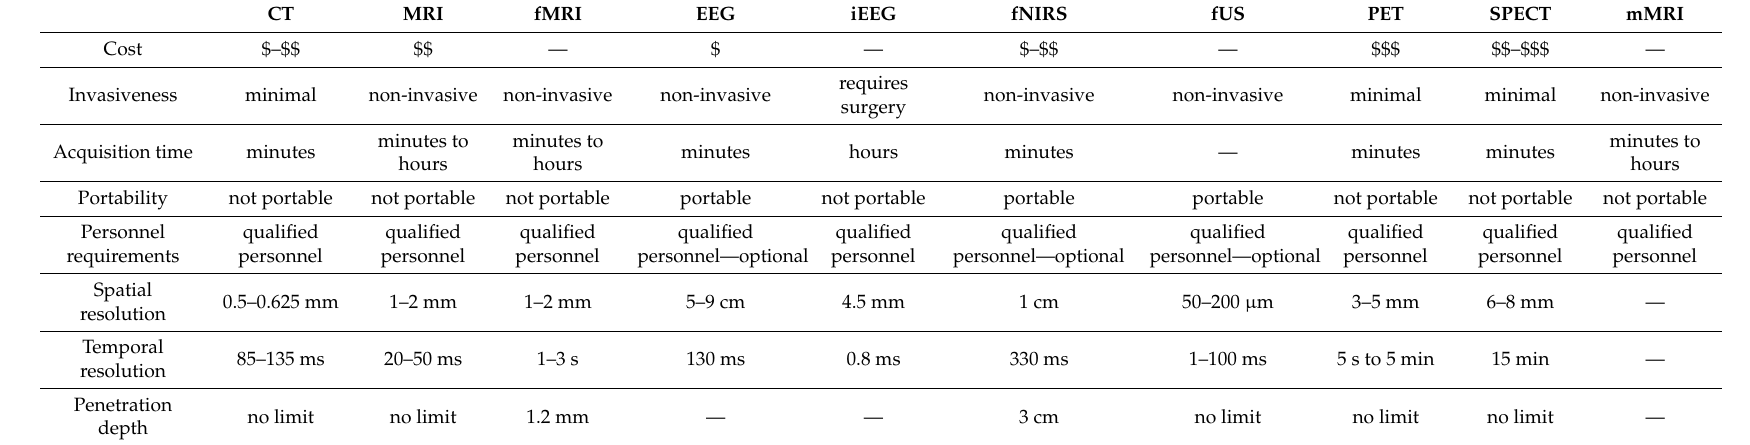
Table 1. A summary of the main characteristics of the neuroimaging techniques previously